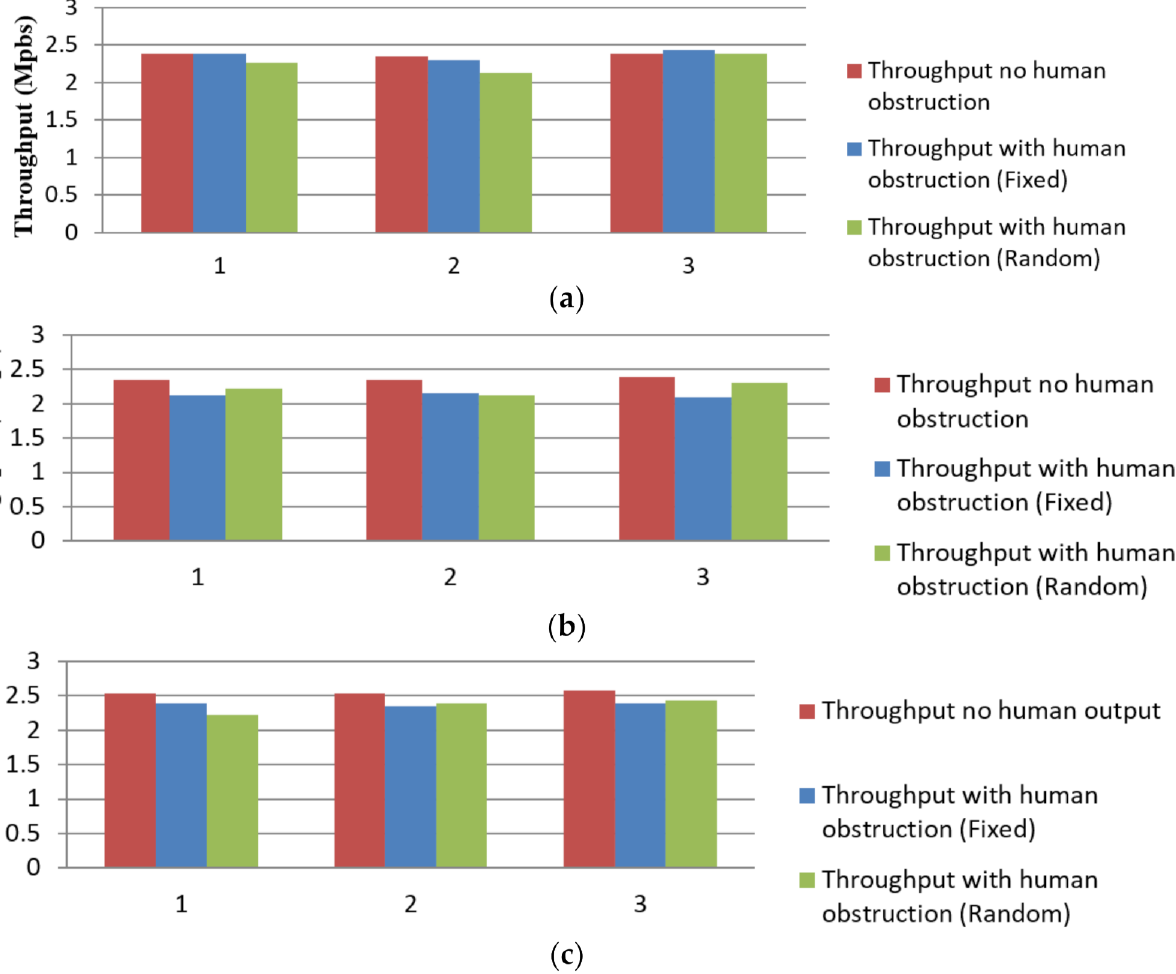
Figure 7. Performance results for the lunchroom environment. ( a ) Lunchroom WT014; ( b ) Lunchroom WT523; ( c ) Lunch- room